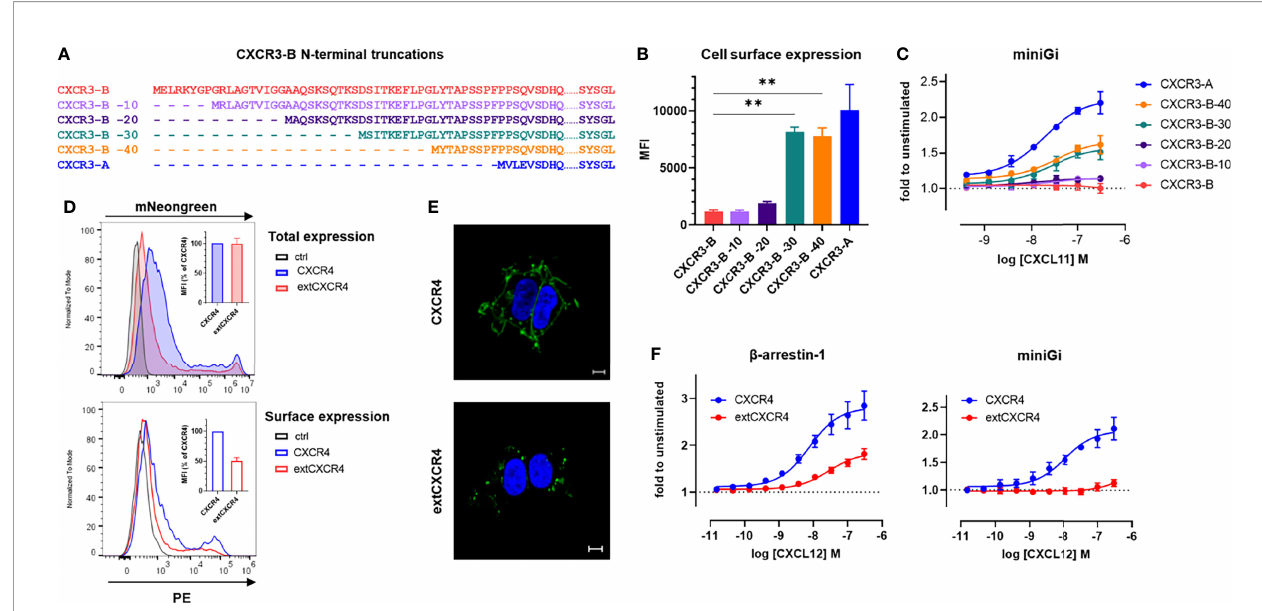
FIGURE 6 | The N-terminal extension of CXCR3-B is responsible for its intracellular localization and lack of G protein coupling. (A) Amino acid sequence comparison of CXCR3-B variants with progressive N-terminal truncations (CXCR3-B -10, CXCR3B -20, CXCR3-B -30, CXCR3B -40). (B) Cell surface expression of CXCR3-B bearing progressive N-terminal truncations determined by fl ow cytometry using the CXCR3-speci fi c mAb 1C6. (C) CXCL11-induced miniGi protein recruitment to N-terminally truncated CXCR3-B determined by NanoBiT-based assay. (D) Receptor expression monitored by fl ow cytometry in cells transiently transfected with vectors encoding CXCR4 or extCXCR4 C-terminally tagged with mNeonGreen or empty vectors (ctrl). Total expression was evaluated as mNeonGreen (upper panel) and surface expression by CXCR4-speci fi c mAb (clone 12G5). Both are quanti fi ed as mean fl uorescent intensity (MFI) and expressed as percentage of CXCR4 (inset). (E) CXCR4 and extCXCR4 cellular distribution visualized by confocal fl uorescent microscopy in cells transiently expressing mNeonGreen-fused CXCR4 or extCXCR4. HEK293T cells were used as cellular background for all the panels. Pictures are representative of 10 acquired images from two independent experiments. Scale bar: 10 m m. (F) CXCL12-induced b